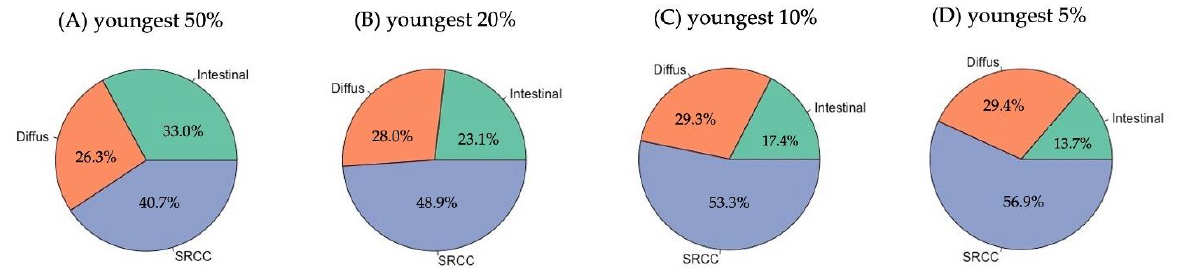
Figure 2. Relative distribution of the three major histological adenocarcinoma subtypes within the population stratified to age percentiles: ( A ) youngest 50% (<72.4 years); ( B ) youngest 20% (<60.4 years); ( C ) youngest 10% (<52.8 years); and ( D ) youngest 5% (<47.1